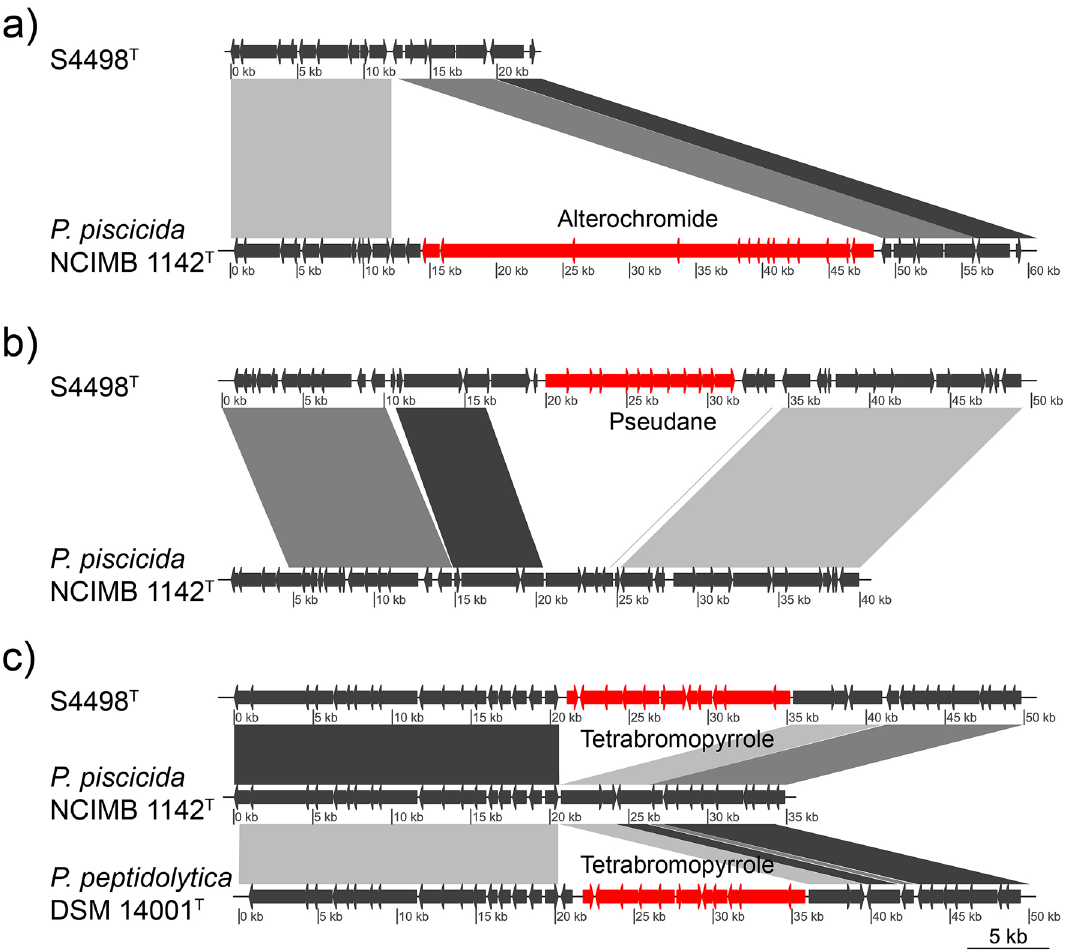
Figure 3. Synteny comparisons of genes surrounding ( a ) the alterochromide cluster in P. piscicida NCIMB 1142 T compared to P. galatheae S4498 T , ( b ) the pseudane cluster in strain S4498 T compared to P. piscicida NCIMB 1142 T and ( c ) the tetrabromopyrrole cluster in P. galatheae S4498 T and P. peptidolytica DSM 14001 T as compared to P. piscicida NCIMB 1142 T . Biosynthetic gene clusters are marked with red and differently grey- shaded bars display homology between